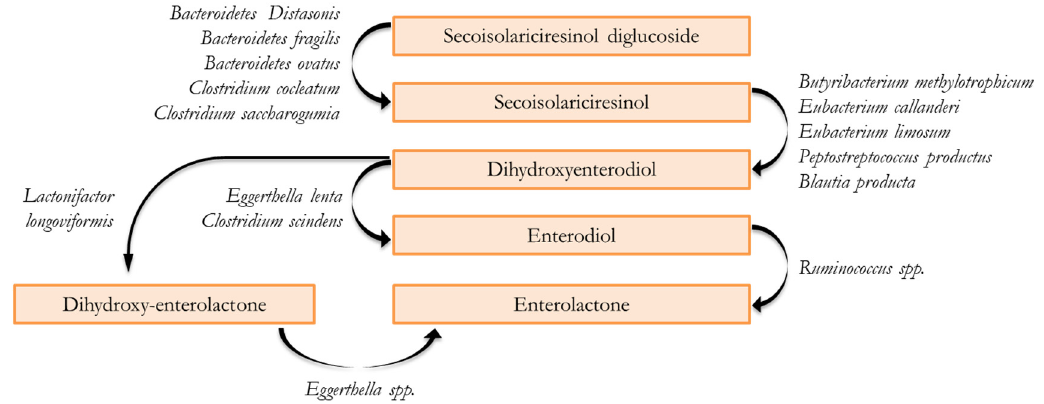
Figure 1. Schematic representation of the fermentative process of lignans.